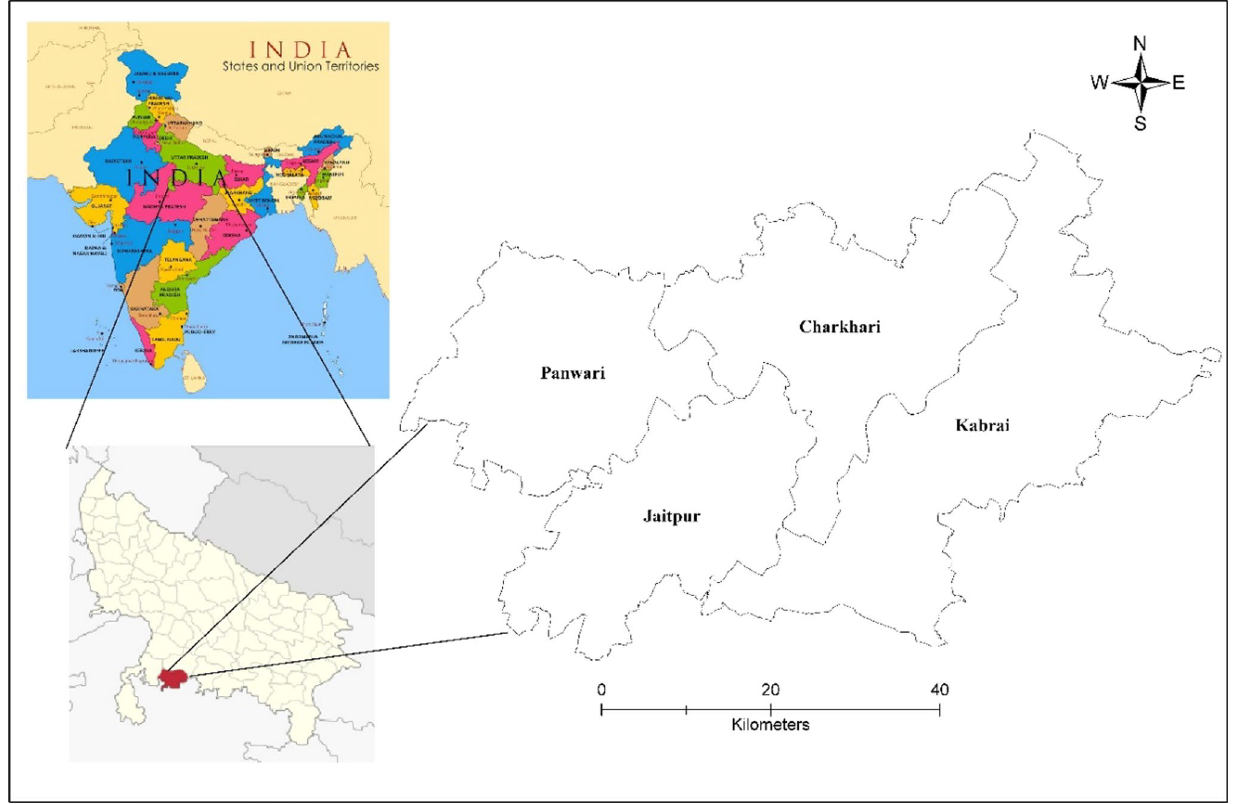
Fig. 1 Map of the study